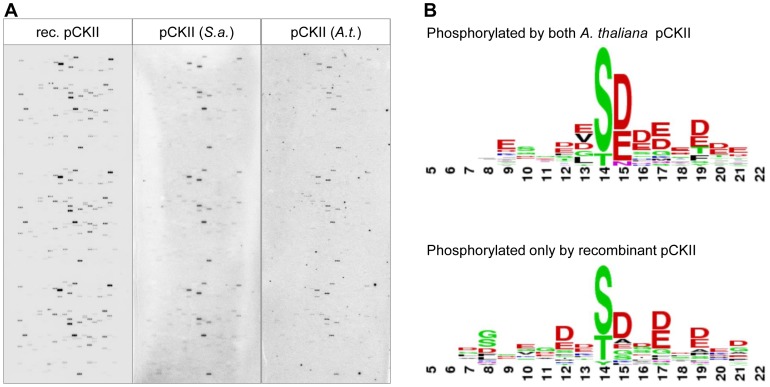
Peptide Chip analysis of preferred pCKII phosphorylation motifs.(A) Peptide Chip results obtained with the different pCKII preparations (B) Phosphorylation site alignment of the peptides used by all pCKII preparations as substrate (upper panel) and peptides phosphorylated exclusively by recombinant pCKII (lower panel). Depicted are the weblogos (http://weblogo.berkeley.edu/) of peptides giving a signal above background (see Materials and Methods for details) with centered phosphorylation sites in 3 bits latitude.